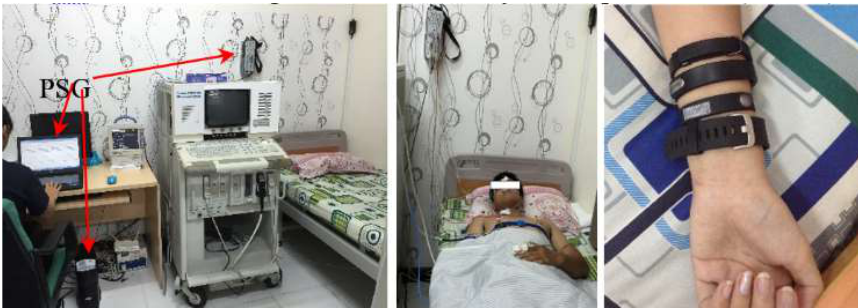
Figure 3. Setup of PSG system and wearable devices for each overnight data acquisition.